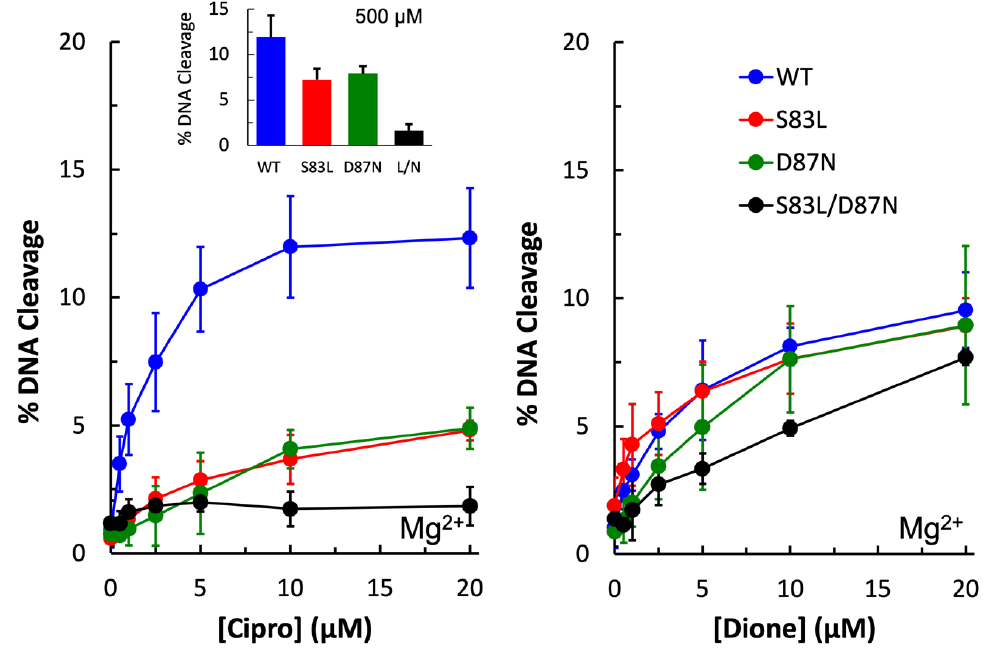
Figure 3. Plasmid DNA cleavage induced by wild-type (blue), GyrA S83L (red), GyrA D87N (green), and GyrA S83L/D87N (black) gyrase enzymes in the presence of 0 – 20 µM ciprofloxacin ( left ) or quinazolinedione ( right ). Mg 2+ was the metal ion. The inset in the left panel shows the level of cleavage induced by the enzymes in the presence of 500 µM ciprofloxacin. Error bars represent the standard deviation of three or more independent experiments.